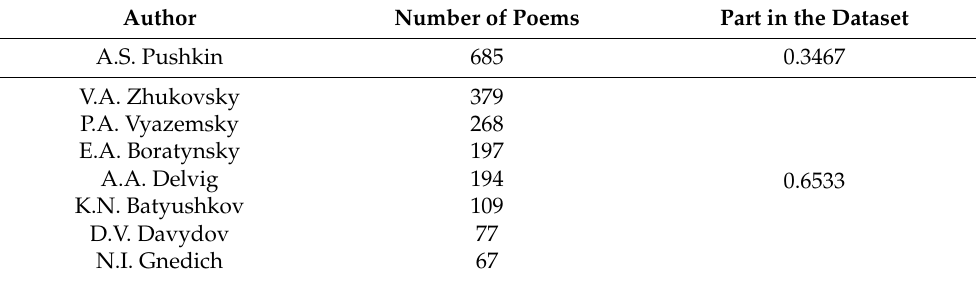
Table 1. Data set of poems by poets of the Pushkin’s era.